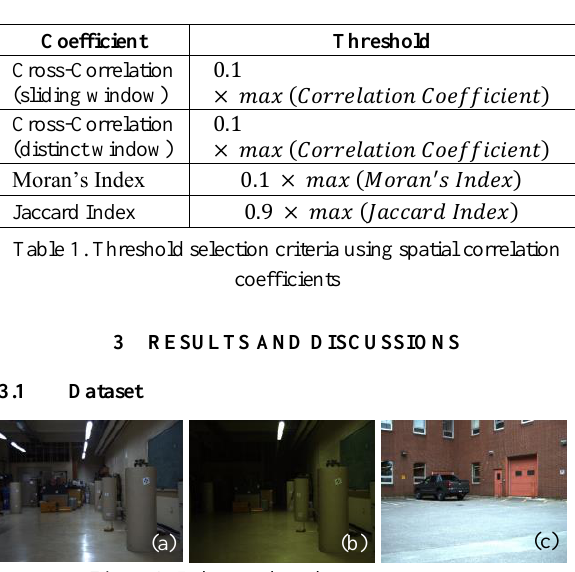
Figure 3. Indoor and outdoor camera scenes